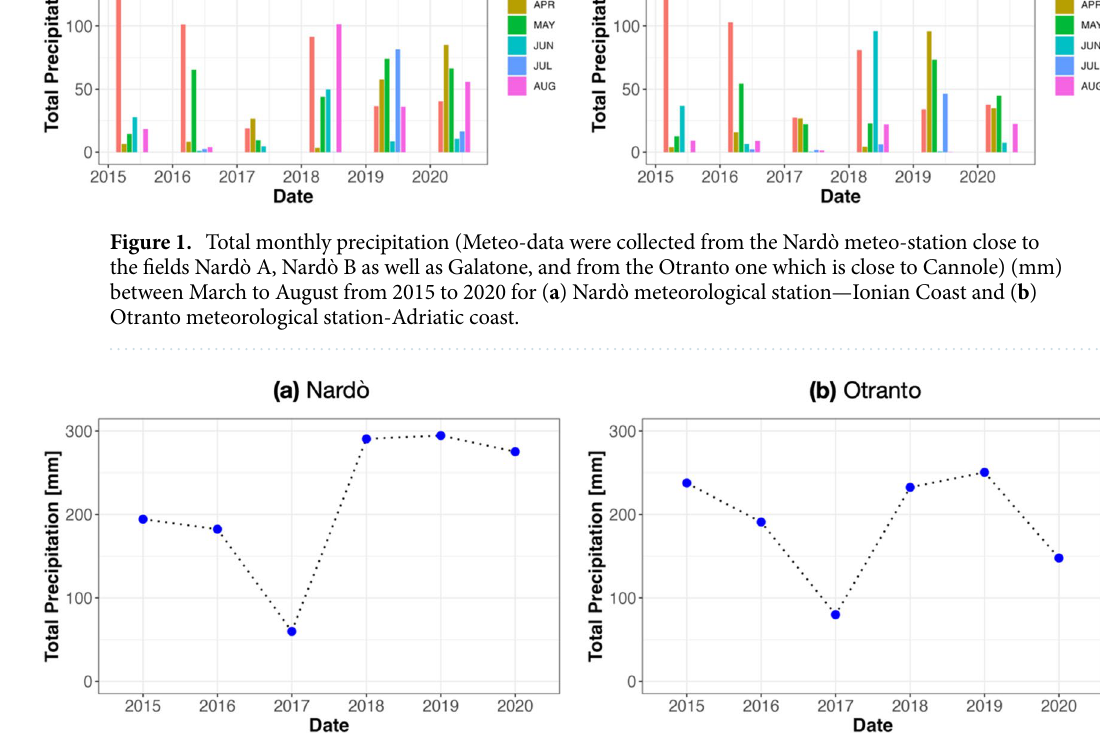
Figure 2. Total spring–summer precipitation (mm) from 2015 to 2020 for ( a ) Nardò meteorological station— Ionian Coast and ( b ) Otranto meteorological station—Adriatic